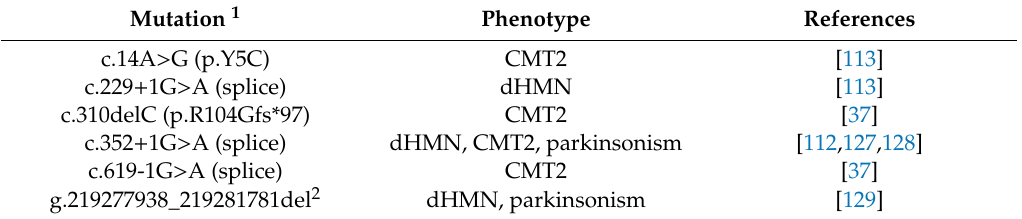
Table 4. DNAJB2 mutations causing neuromuscular disease. CMT2: Charcot–Marie–Tooth disease type 2, dHMN: distal hereditary motor